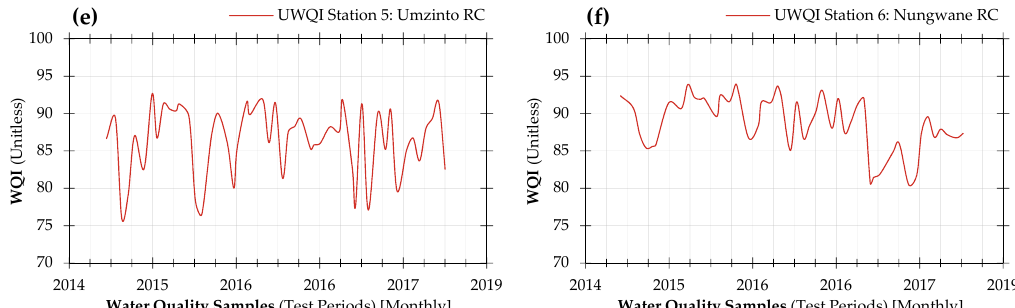
Figure 5. Water quality index results calculated using the developed universal water quality index (UWQI) for Umgeni water quality data for a period of four years from June 2014 to July 2018 ( a ) Umgeni River catchment for Henley Dams, ( b ) Umdloti River catchment for Hazelmere Dam, ( c ) Umgeni River catchment for Inanda Dams, ( d ) Umgeni River catchment for Midmar Dam, ( e ) Umzinto/uMuziwezinto River catchment for Umzinto Dam, and ( f ) Nungwane River catchment for Nungwane Dam. Table 7. Water quality index matrix for the six sampling stations.